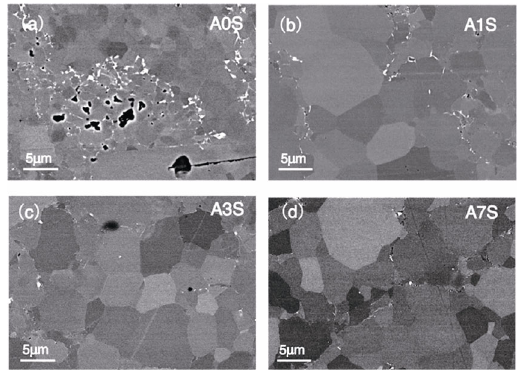
Fig. 2 BSE images of the samples A0S, A1S, A3S, and A7S.